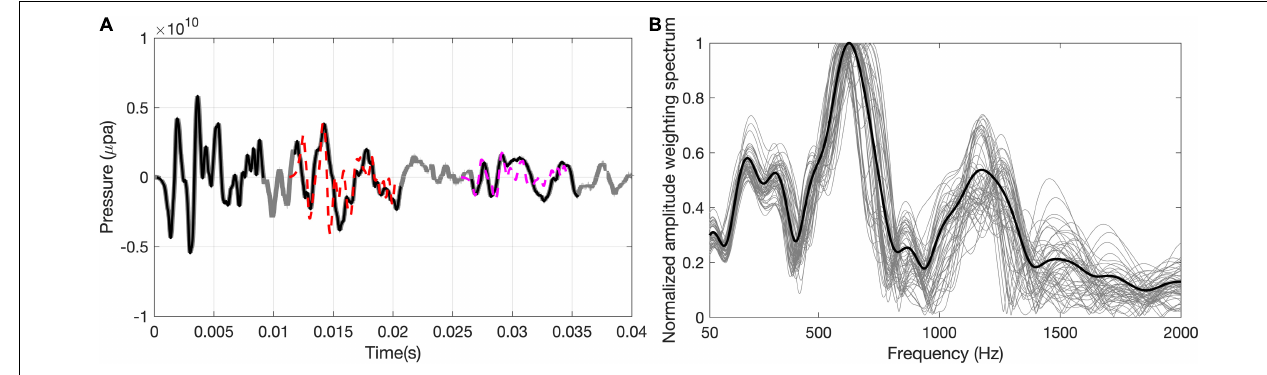
FIGURE 2 | (A) Ensemble average of 55 waveforms acquired by a hydrophone placed 4 m above the water-sediment interface at distances of 15–24 m from the turbine 17. (B) Normalized amplitude-weighting spectrums estimated from the 55 first phase waveforms and their average spectrum (thick black line), which was used in the broadband PE simulation.